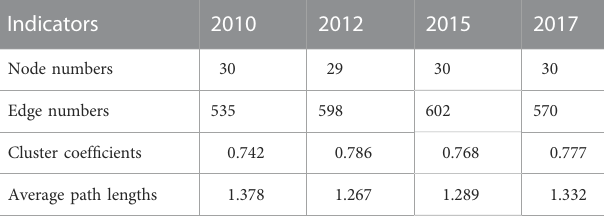
TABLE 3 Characteristics of the